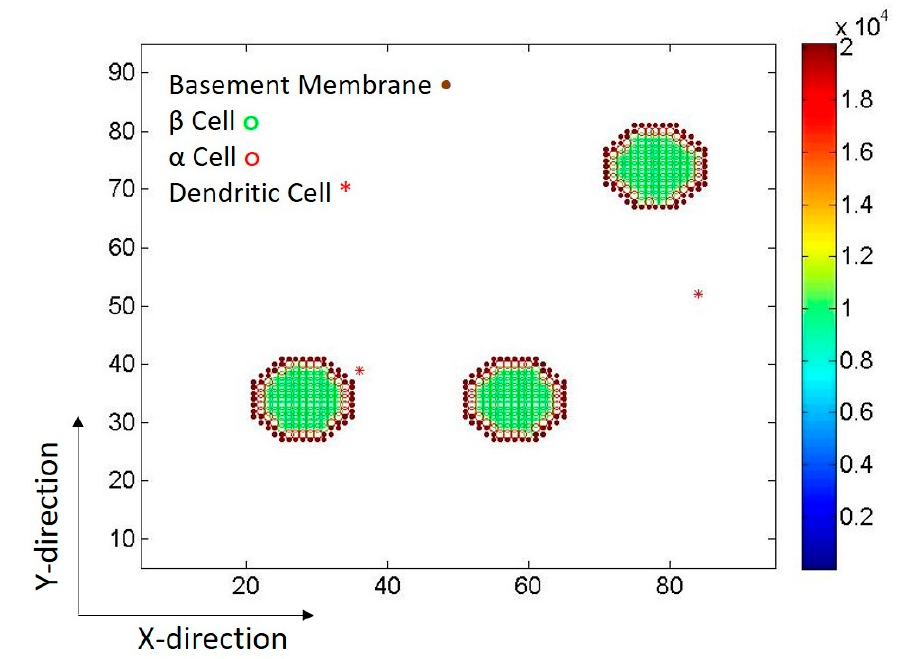
Figure 1. Islet cell arrangement in two-dimensional space grid. α cells (red circle) surround β cells (green circle) and Basement Membrane (BM) (brown dot) encloses all the cells. Islets present core-mantle structure. Color bar shows strength value of BM during disease progression during a simulation.